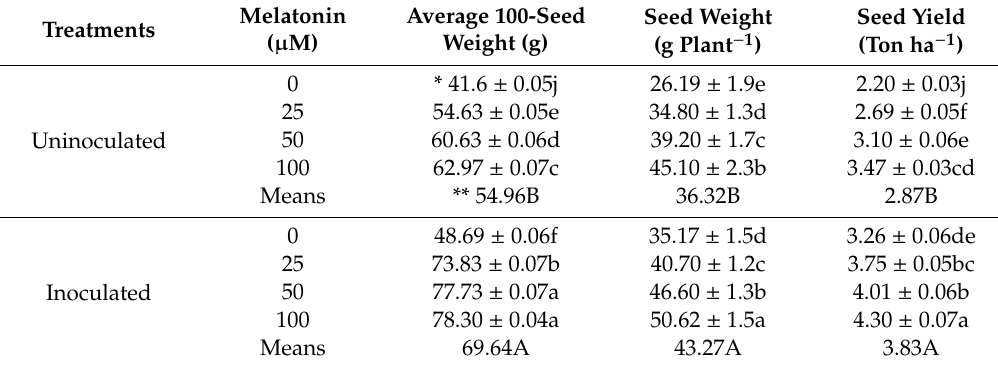
Table 4. E ff ect of EPS-producing bacteria and melatonin on yield components of faba bean grown in location one (saline soil).